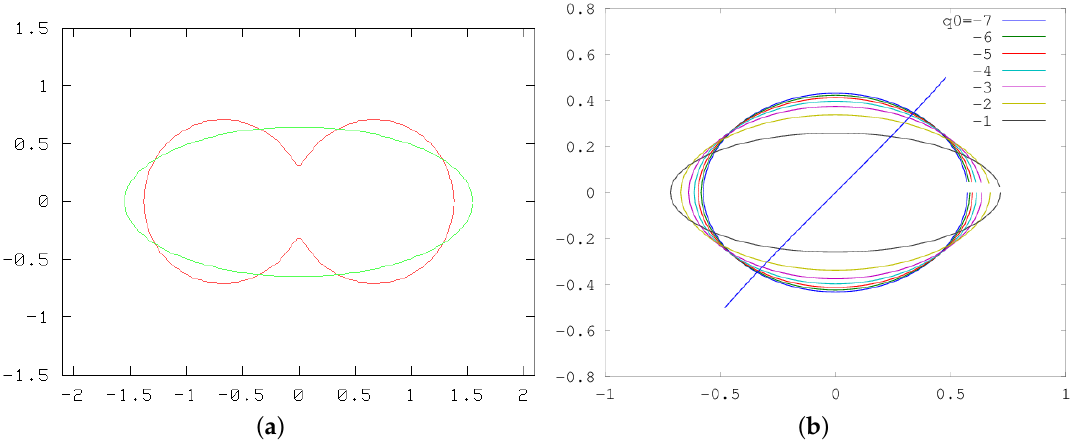
Figure 2. DBSA for contour dynamics with the two constraints L and K of (42) and (44), respectively. ( a ) Relaxation to the elliptical V-state with 2-fold symmetry (Kirchhoff ellipse). ( b ) Relaxation to an elliptical state in the presence of shear (Kida ellipse) for various anomalies q 0